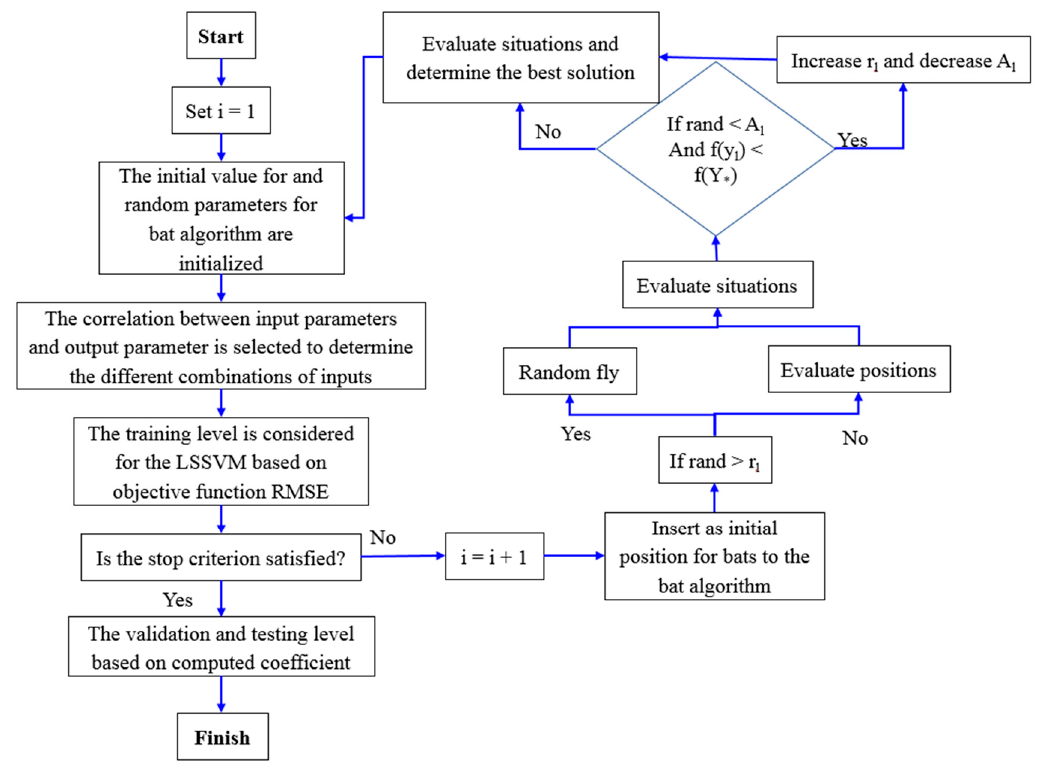
Figure 2. The flowchart showing the LSSVM–Bat Algorithm (BA) algorithm.